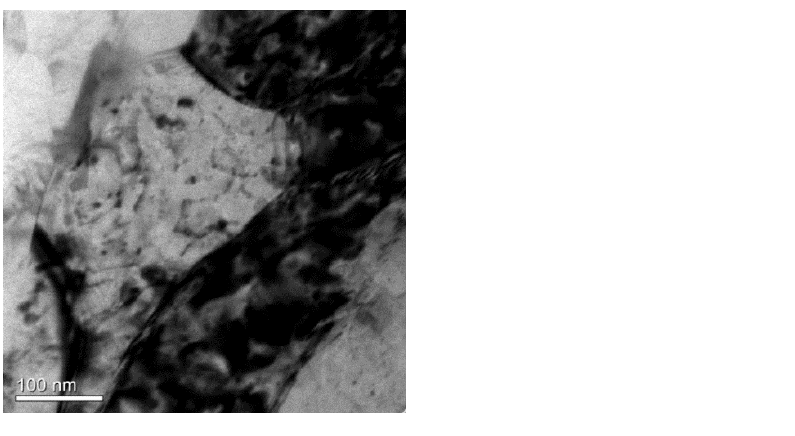
Figure 6. TEM micrograph of as-forged RF50 showing a nano-sized grains with dense dislocation loops. Table 3. EDX Spectrum and Constituted Phases for Dispersoids in Different Samples. (wt.%). Al